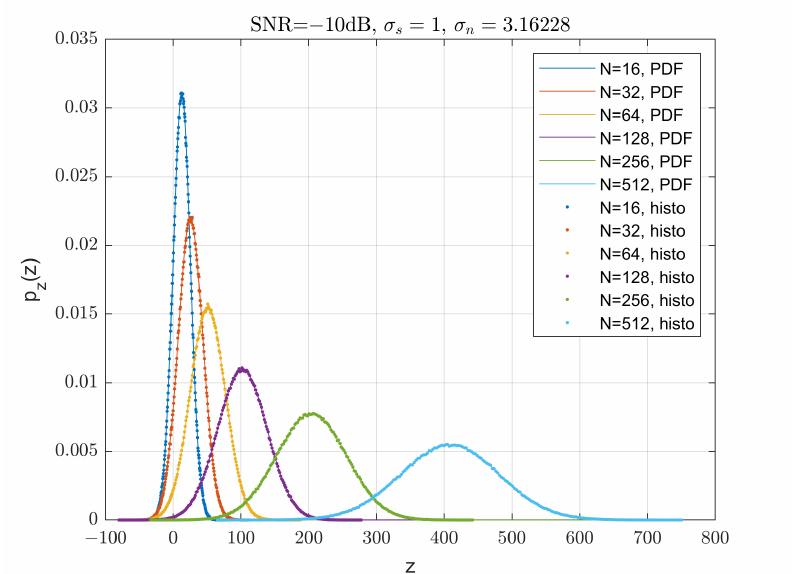
Figure 13. A selection calculated PDFs of the decision variable p z ( z ) and Monte Carlo histograms. In numerical